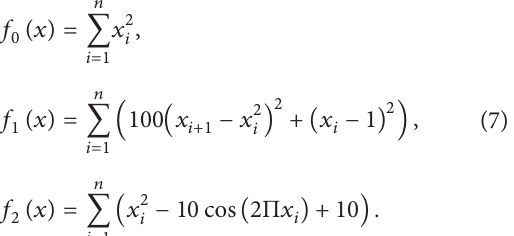
Figure 3: SVM parameter optimization using